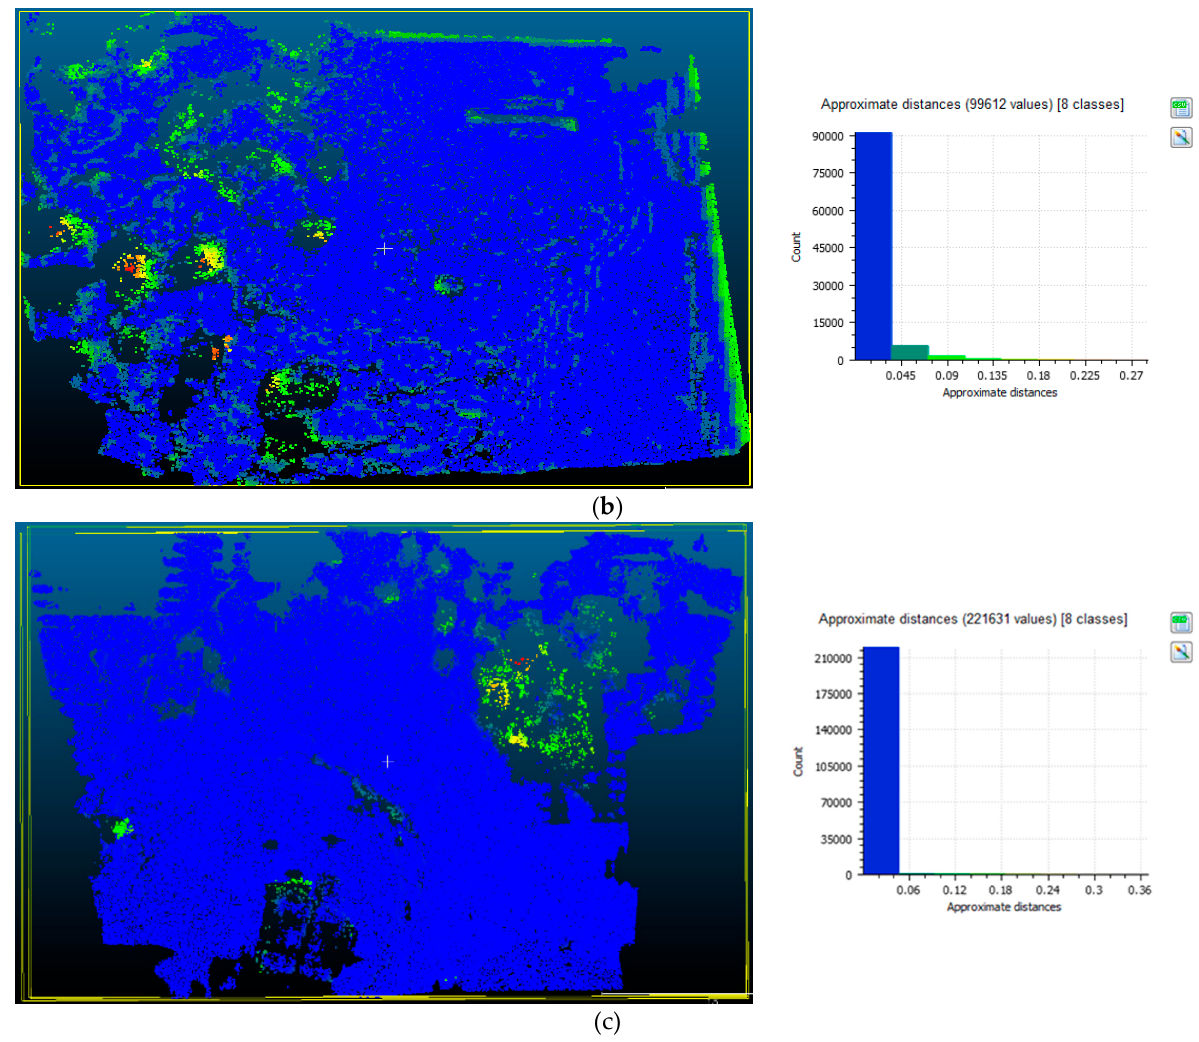
Figure 10. The differences between the generated point clouds by Agisoft and the proposed method from ( a ) the first, ( b ) second, and ( c ) third datasets.